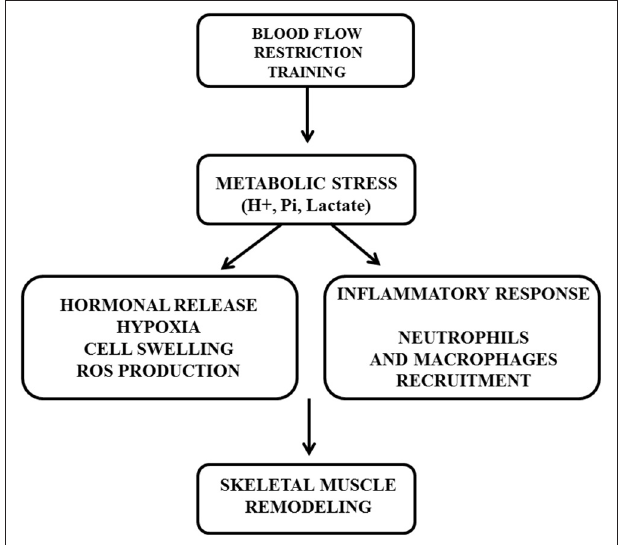
FIGURE 1 | The role of metabolic stress (H + , Pi, Lactate) leading to anabolic signaling (hormonal release, hypoxia, cell swelling, ROS production) and inflammatory response induced by blood flow restriction training for enhancing muscle adaptations.